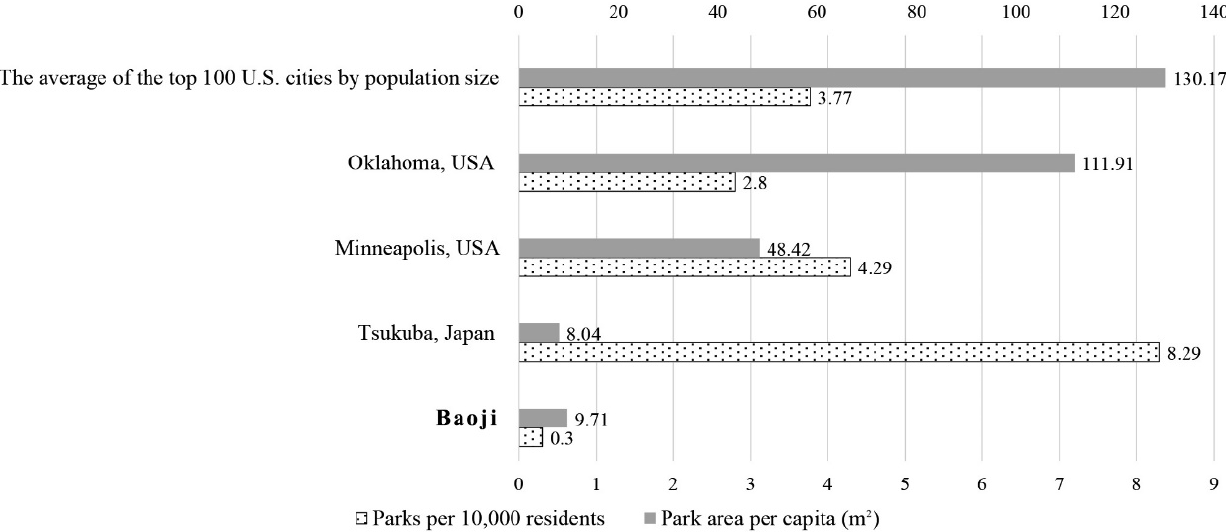
Figure 5. Comparison of urban park systems between Baoji and foreign cities.